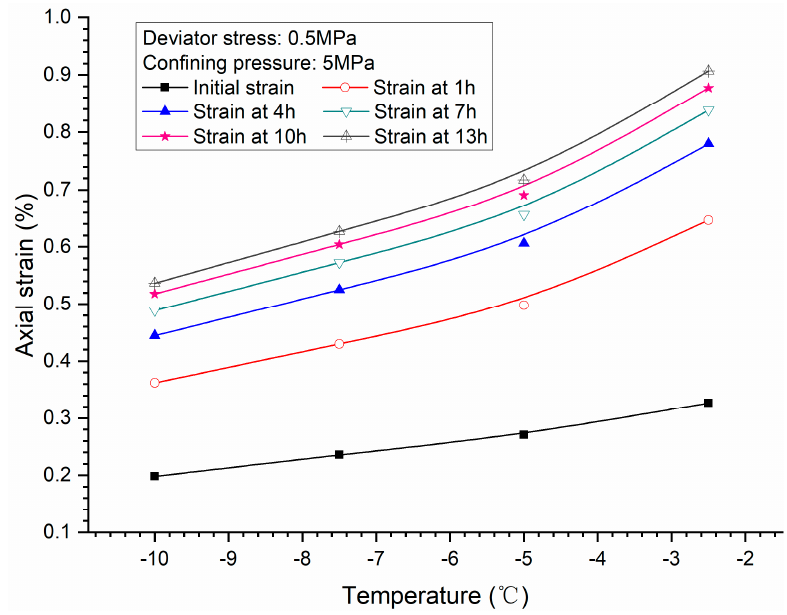
Figure 14. Initial strain and axial strains versus temperature for methane hydrate-bearing frozen specimens.